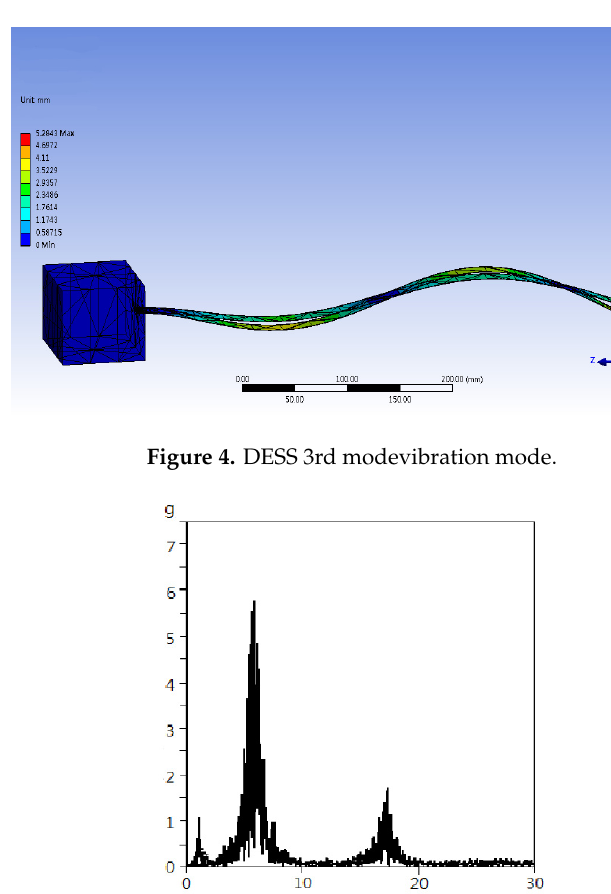
Table 2. SESS (single elastic steel sheet) power generated at the root and the peak of the first mode .